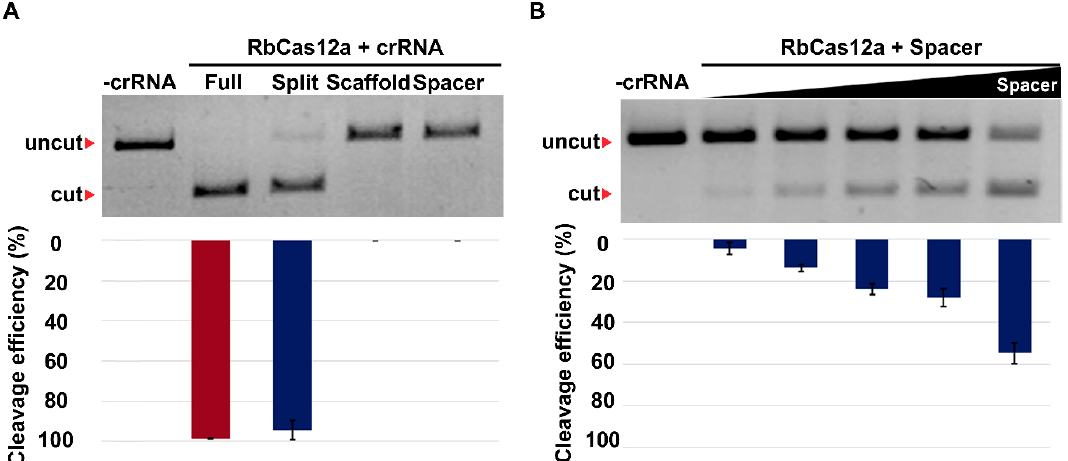
Figure 5. Effect of time on RbCas12a/crRNA and AsCas12a/crRNA cleavage activity. Target DNA cleavage by AsCas12a or RbCas12a programed with 500 nM crRNA at 1:3:30 target:Cas12a:RNA ratio. Mean cleavage efficiencies and standard deviations calculated from three independent experiments are shown.